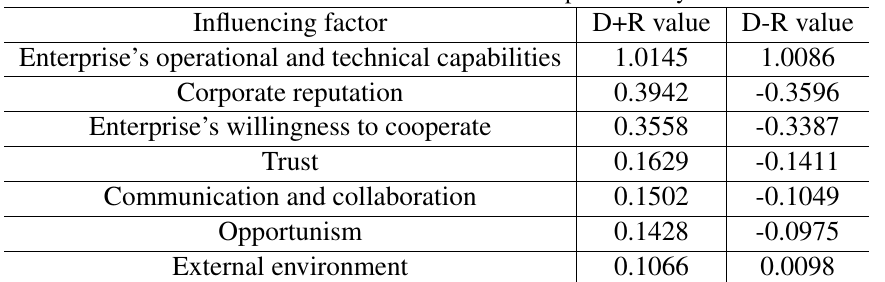
Table 3 GRNN-DEMATEL method based empirical analysis